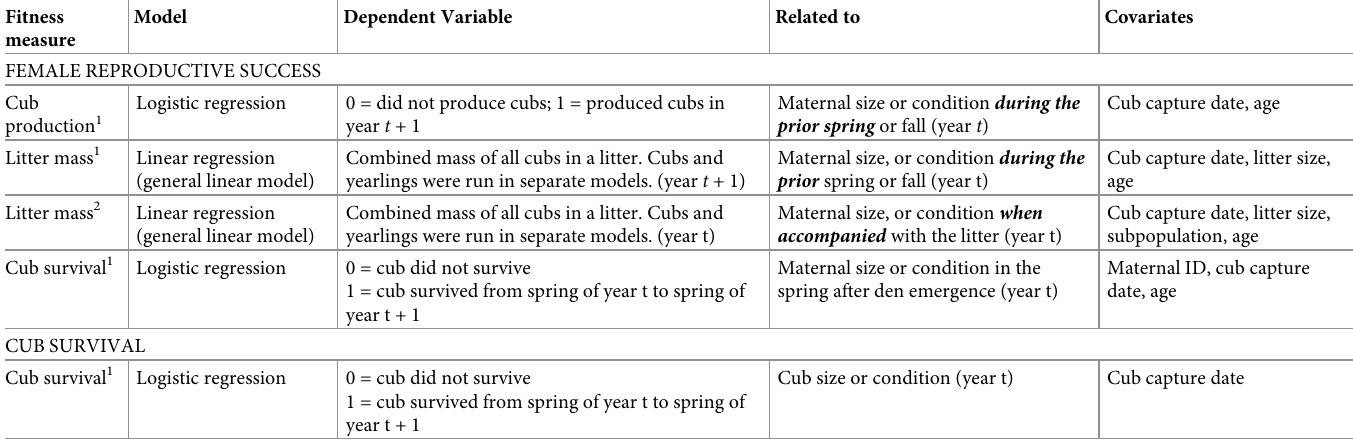
Table 2. The structure and covariates included in candidate models used to identify body size and condition measures that were related to indices of female repro- ductive success and cub